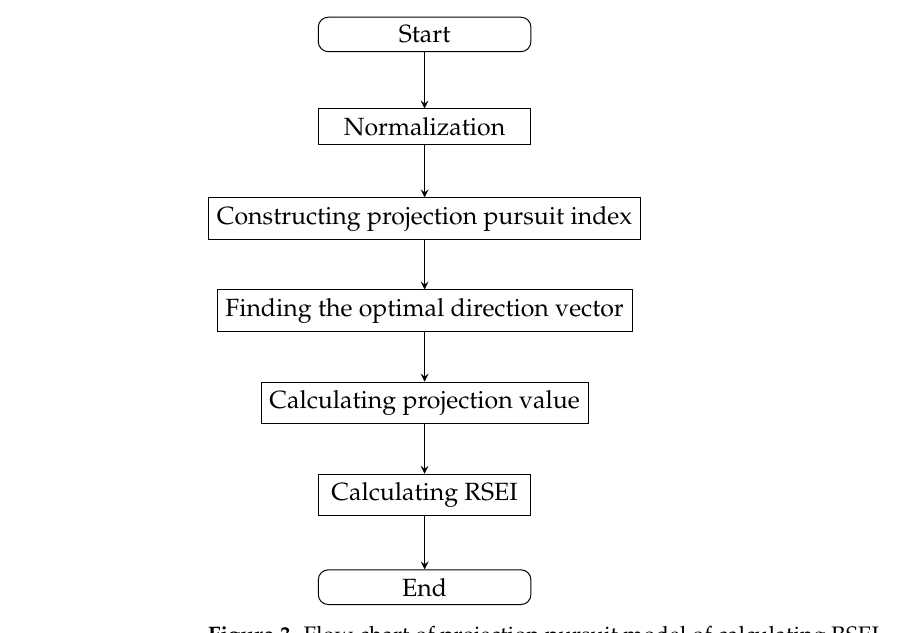
Figure 3. Flow chart of projection pursuit model of calculating RSEI. Step 1: